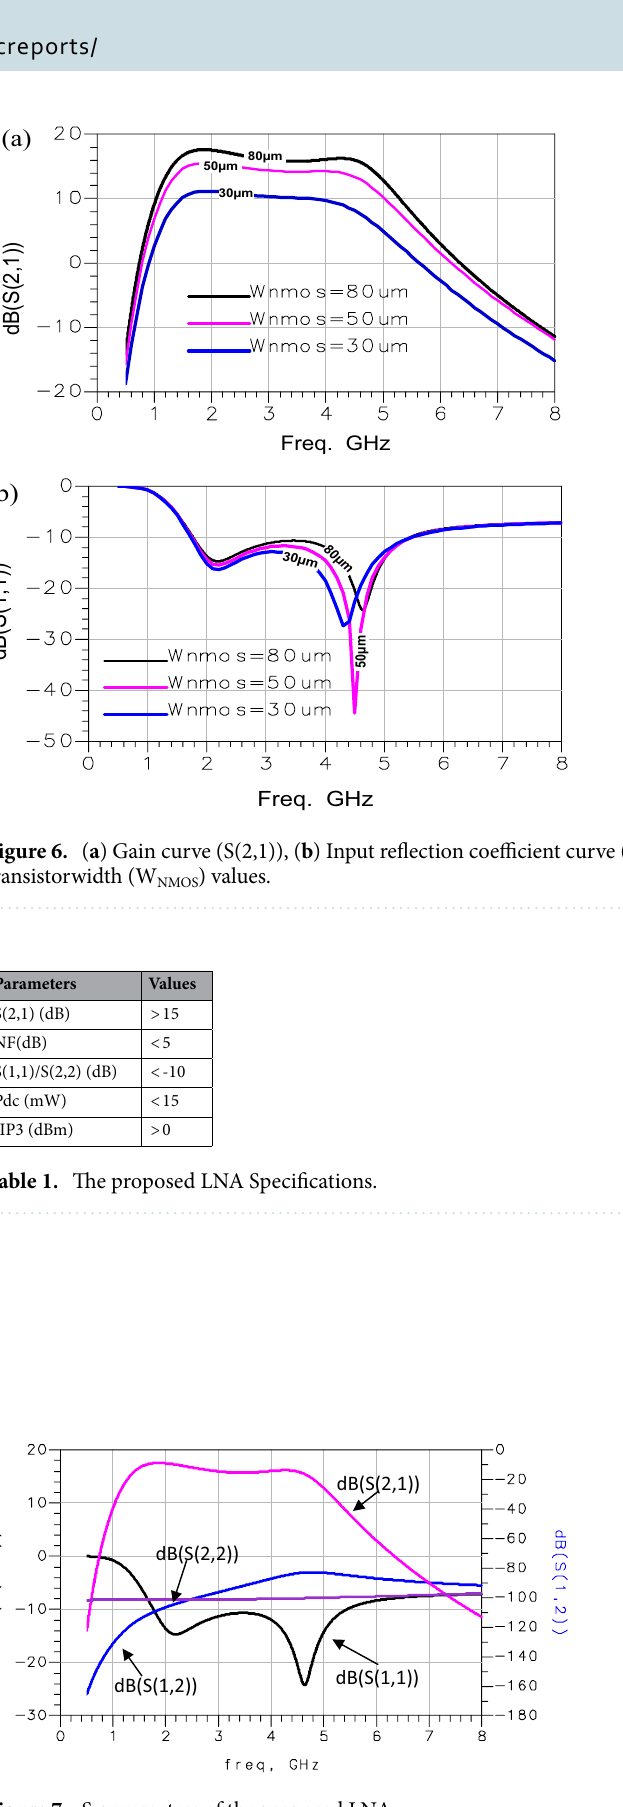
Figure 7. S-parameters of the proposed